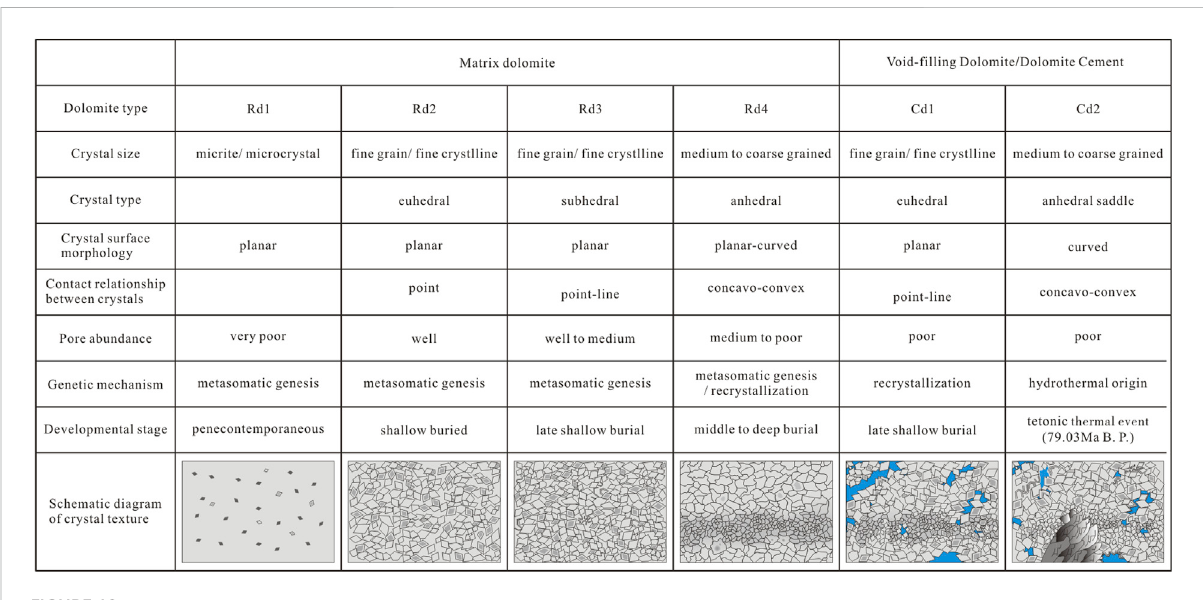
Figure 9), indicating that Cd1 experienced diagenetic